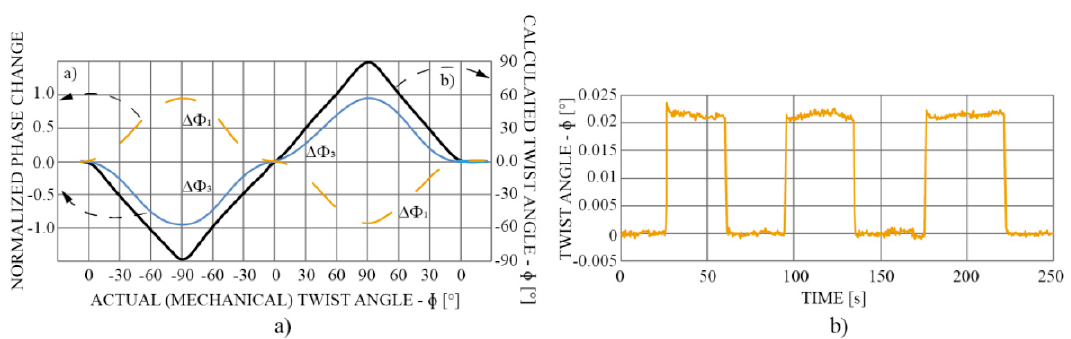
Figure 3. ( a ) Calculated twist/rotation angle from diametrically opposite FPIs’ phases measurement and ( b ) Minimum resolution measurements when rotating the rotation stage for 0.02° in the CW